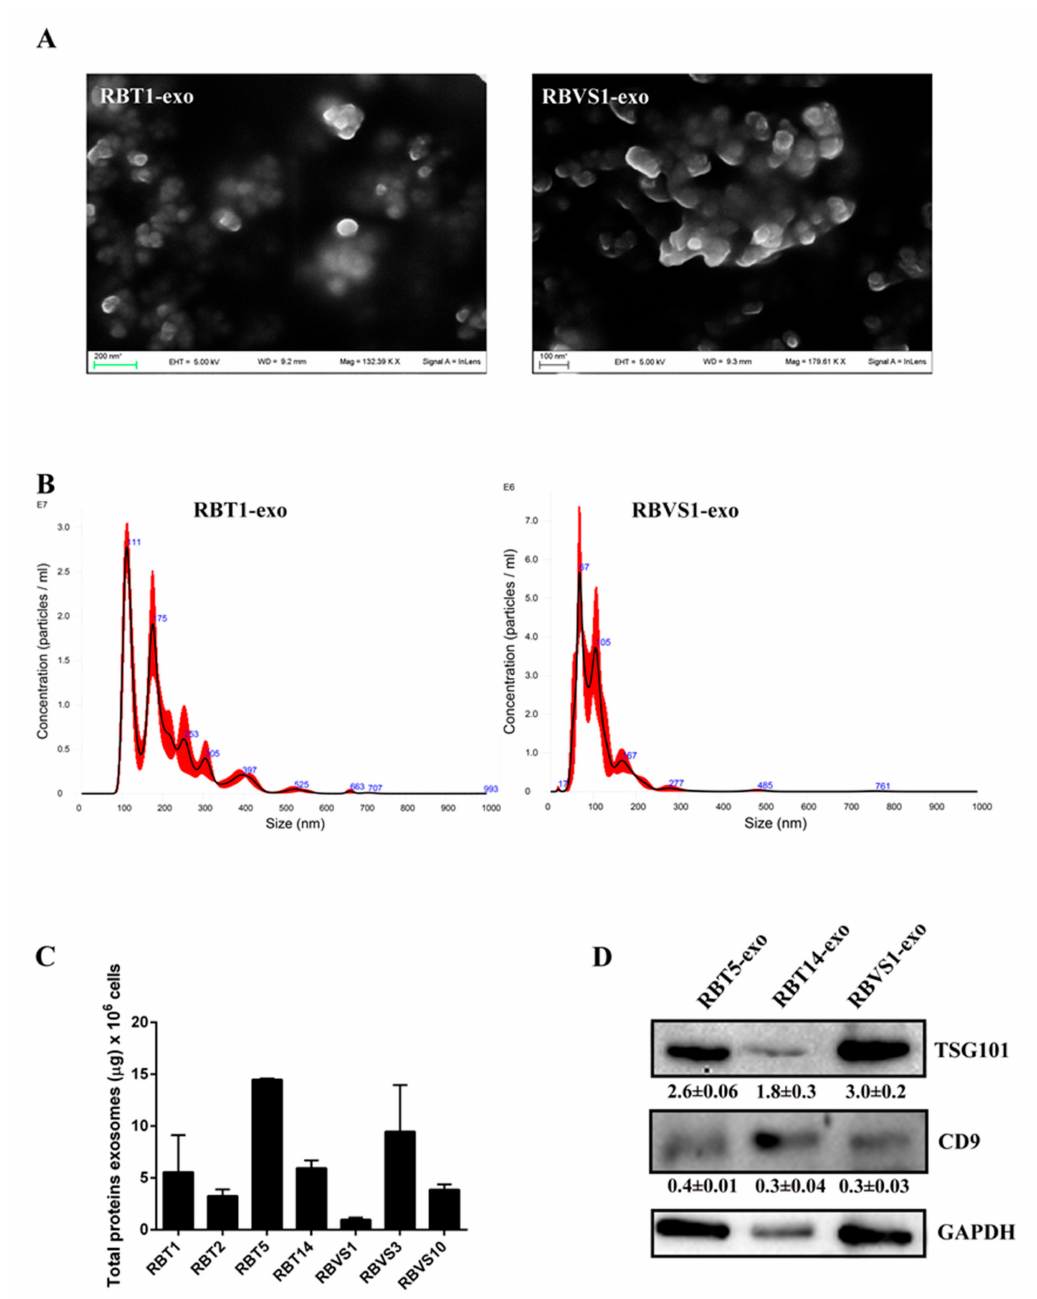
Figure 1. Characterization of retinoblastoma tumor (RBT)- and RB vitreous seeding (RBVS)-derived exosomes. ( A ) Scanning electron microscopy (SEM) showing a population of heterogeneous-sized exosomes isolated from representative RBT1 and RBVS1 cell lines. Scale bar: 200 nM. A higher magnification image was reported for RBVS1. Scale bar: 100 nM. ( B ) Graphics representing size distribution of nanoparticles resulting from NanoSight particle-tracking analysis of RBT1 and RBVS1, taken as representative of all RB cell lines. ( C ) Quantity of total exosomal protein for 10 6 cells of the di ff erent RB cell lines analyzed. ( D ) Western blot analysis of the typical exosomal proteins, TSG101 and CD9 for two RBT and one RBVS representative cell lines. GAPDH was reported as loading control. Detailed information about western blot can be found at Figure